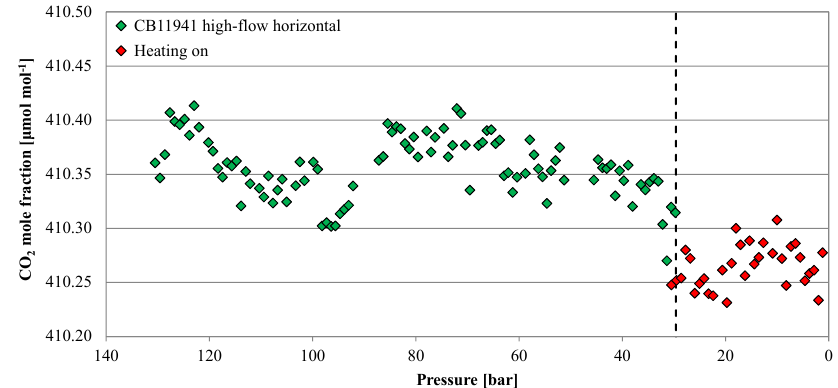
Figure 15. CO 2 mole fraction of a high-flow experiment as a function of pressure; note the inverse x axis. The cylinder (CB11941 on 22 June 2017) was horizontally positioned throughout the whole experiment. The CO 2 mole fraction was measured down to 30bar (green diamonds). At 30bar (indicated by the dashed line), the flow was interrupted and the cylinder was heated up to 30 ◦ C; after the set temperature was reached, the CO 2 measurement continued (red diamonds). The heating caused a small pressure increase, which is why the first two points of the resumed measurements appear slightly above the pressure threshold of